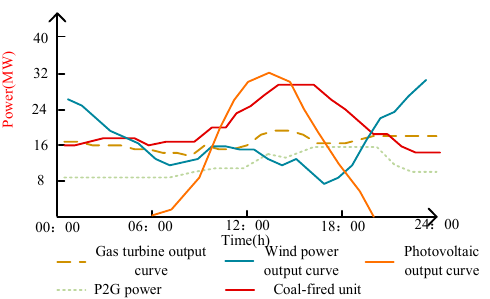
Figure 5. Operation plan of each unit under Scenario 2.